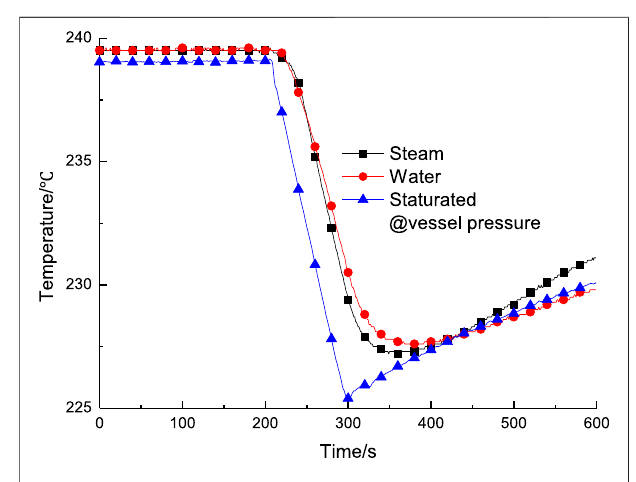
FIGURE 6 | Vessel content temperatures of the fast